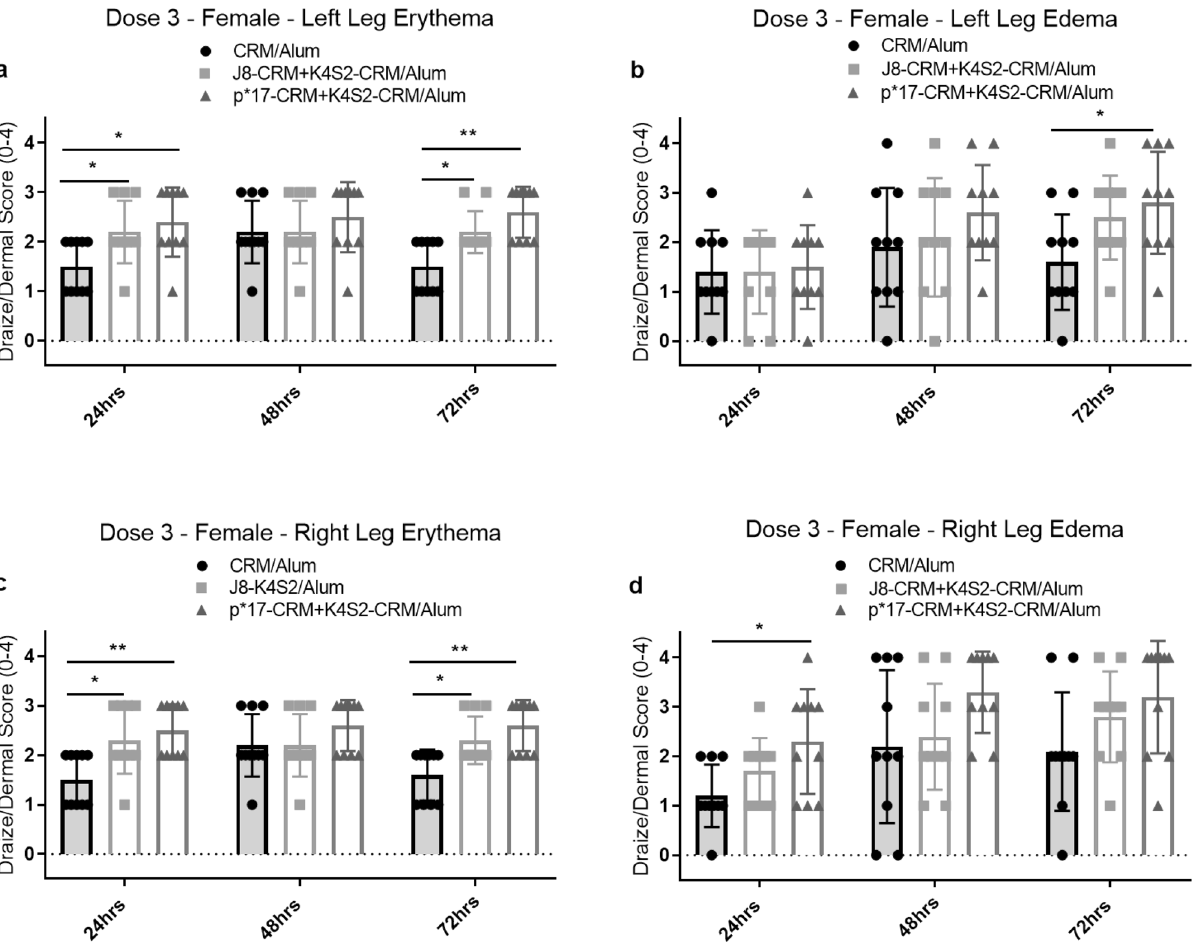
Figure 2. Female Draize scoring after third dose (day 43). Draize scores are treated as replicates (n = 10), for each clinical observation, at a given time point. All four clinical observations; ( a ) left leg erythema; ( b ) left leg edema; ( c ) right leg erythema and ( d ) right leg edema are shown for each time point. Data for an observation, at a given time point, is displayed as group score mean with SD. Statistical analysis and graphs generated